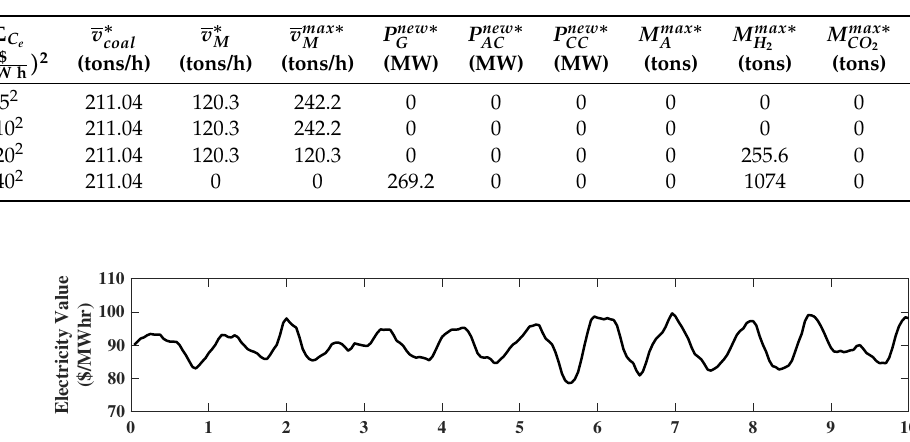
Figure 14. Value of electricity and the resulting power generation dispatch for the case of Σ C ( $5/MW h ) 2 and C = 100 $/ton MeOH. M